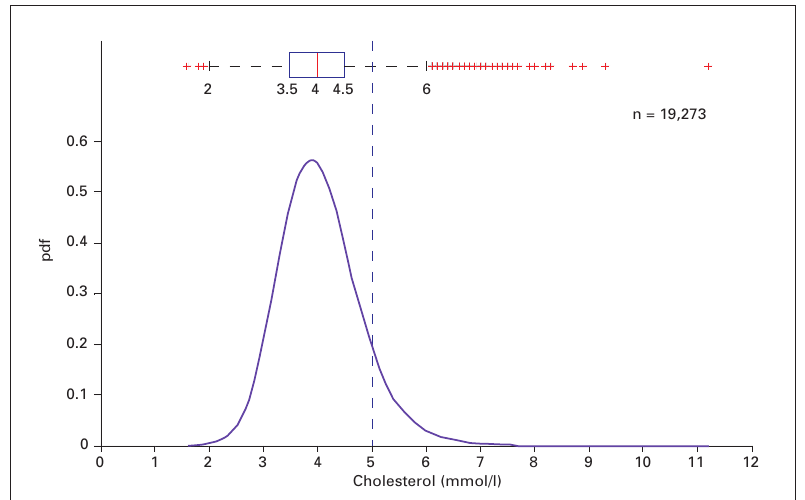
Figure 1 Distribution of total cholesterol levels in young Swiss male conscripts. Sample averages: height: 178.1 cm, weight: 72.6 kg and body mass index: 22.86 kg/m 2